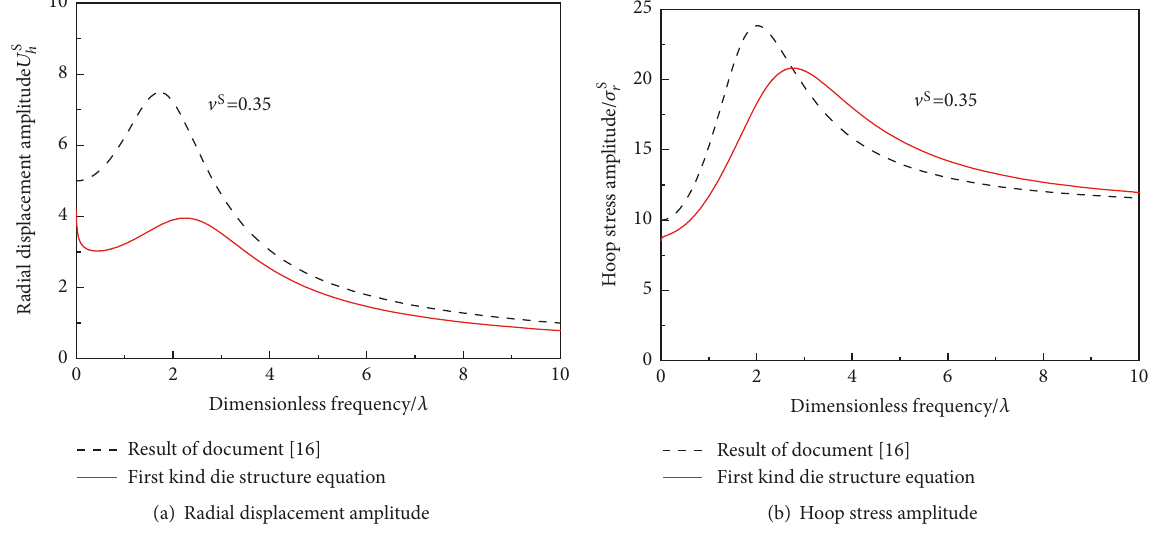
Figure 2: Comparison between present results and [16]